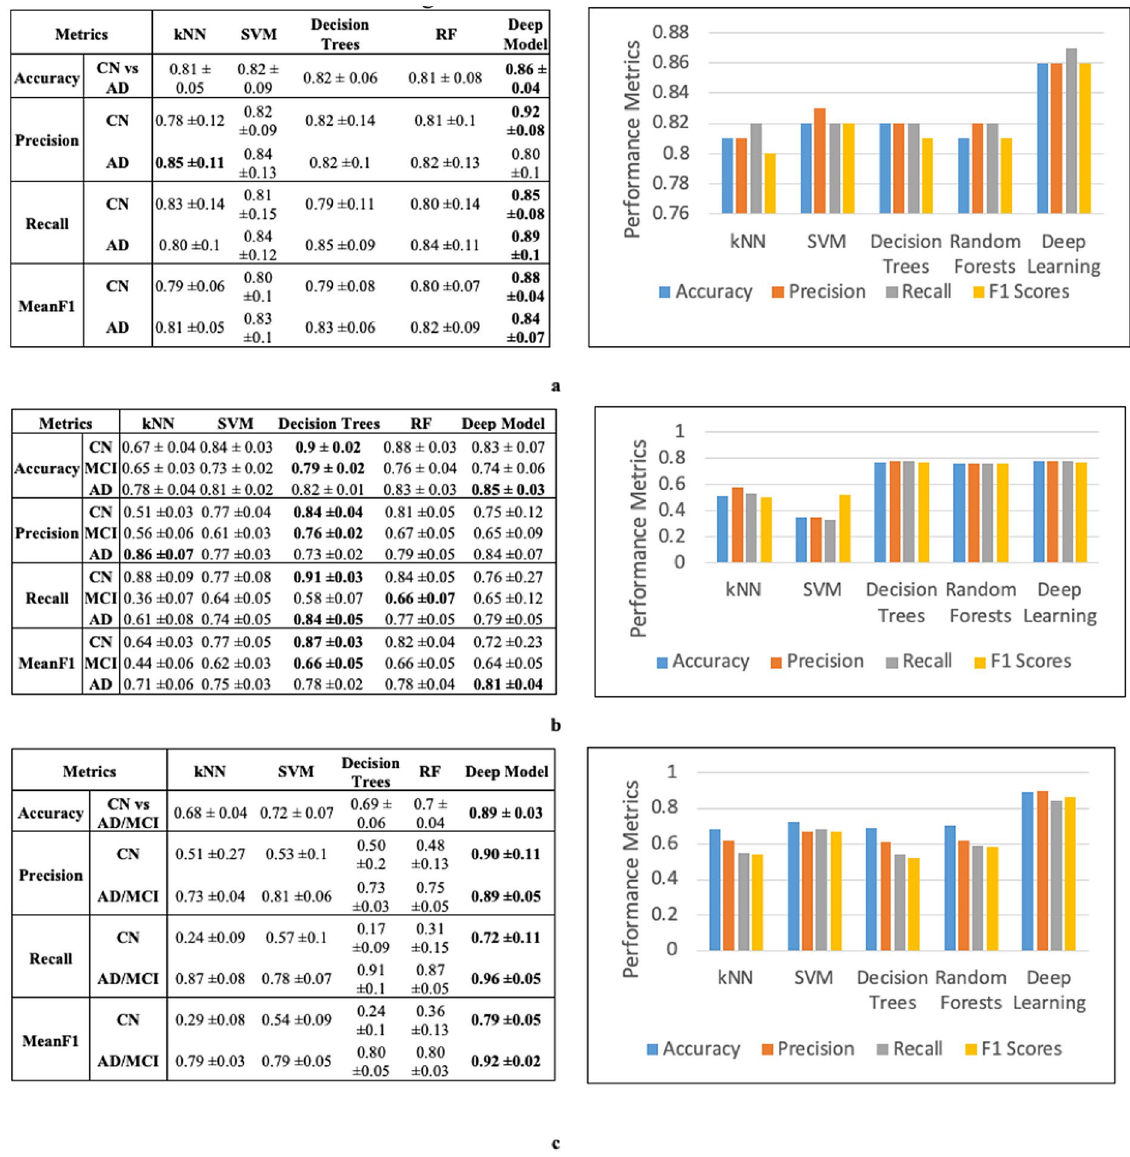
Figure 4. Internal cross validation results for individual data modality to predict Alzheimer’s stage ( a ) Imaging results: deep learning prediction performs better than shallow learning predictions ( b ) EHR results: deep learning outperforms shallow models kNN and SVM and is comparable to decision trees and random forests ( c ) SNP results: deep learning outperforms shallow models. The kNN, SVM, RF and decision trees are shallow models. ( kNN k-Nearest Neighbors, SVM support vector machines, and RF random